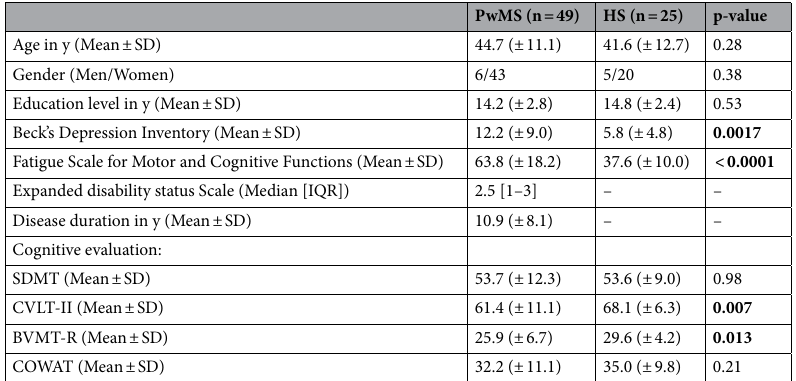
Table 1. Demographics and cognitive scores of the PwMS and HS group. P-values were generally derived from two-sample t-tests, with the exception of a Chi-square test for age. (y: years; IQR: Interquartile range). p-values below the statistical threshold of significance (0.05) are indicated in bold.